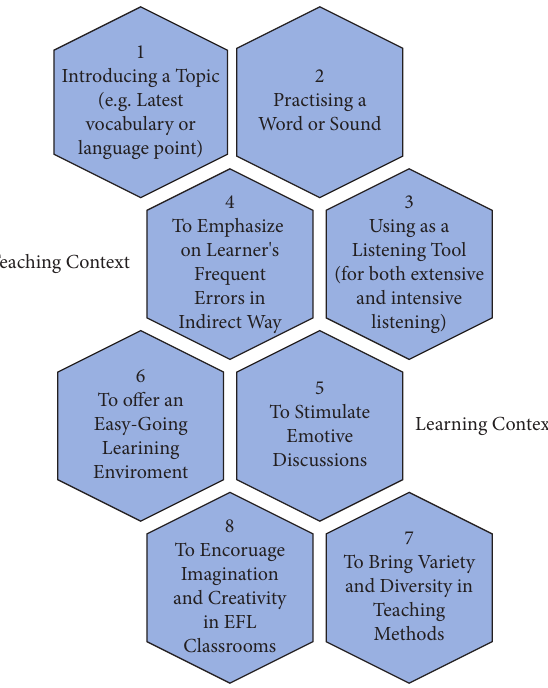
Figure 1: Eight motives behind using songs in EFL classrooms by Eken